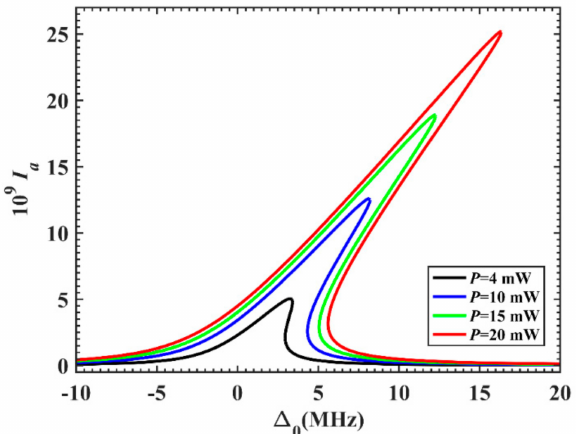
Figure 5. Curves of the mean intracavity photon number versus cavity mode-pump field detuning under the condition with di ff erent pump field power, where γ 13 = γ 12 = γ 14 = γ , ∆ 1 = γ , ∆ = ∆ = 2 γ , Ω = Ω = 4.5 Ω = 2 3 2 0 , g 1